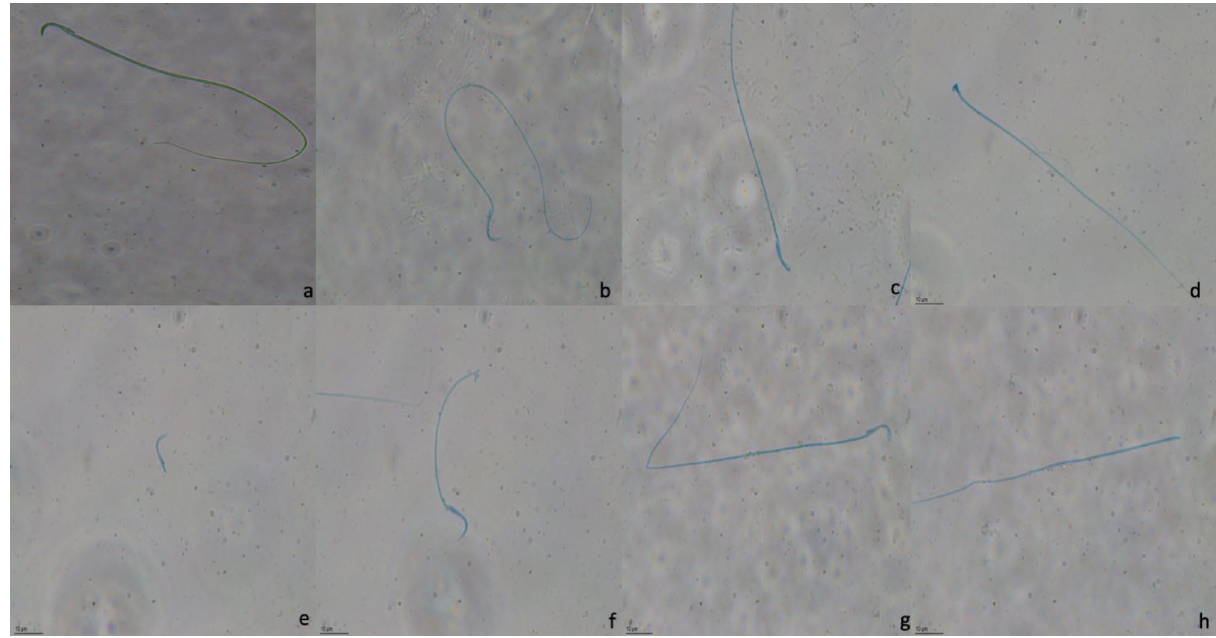
Figure 1. Sperm morphology observed under ×60 magnification following OLZ administration ( a ) Normal; head abnormalities; ( b ) bent neck; ( c ) banana; ( d ) amorphous; ( e ) Detached; ( f ) broken tail; ( g ) bent tail; ( h ) headless; tail